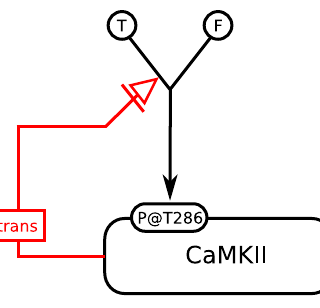
Figure 2.25: The Entity Relationship glyph for necessary stimulation .